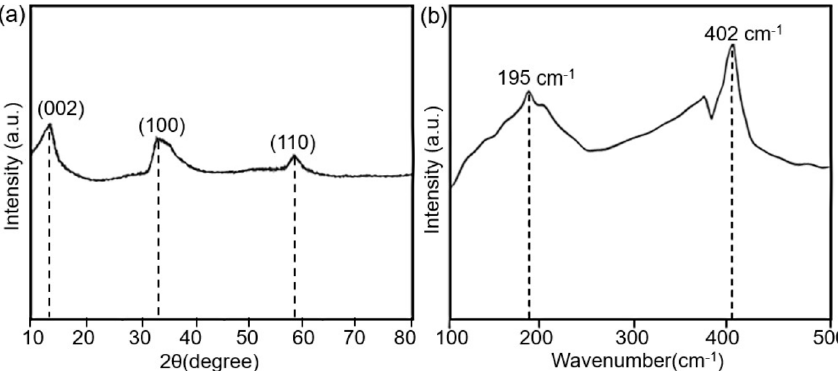
Figure 5. Material characterizations of the synthesized MoS 2 nanostructures. ( a ) The XRD spectrum of MoS 2 . ( b ) The Raman spectrum of MoS 2 .